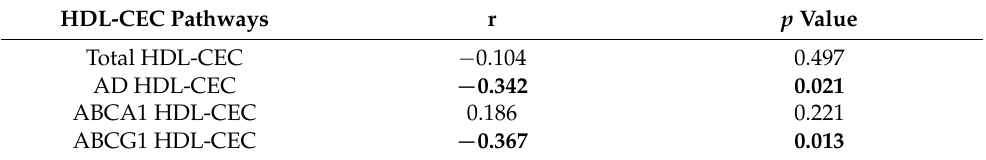
Table 2. Correlation between HDL cholesterol efflux capacity (CEC) and Achilles tendon thickness. HDL-CEC pathways